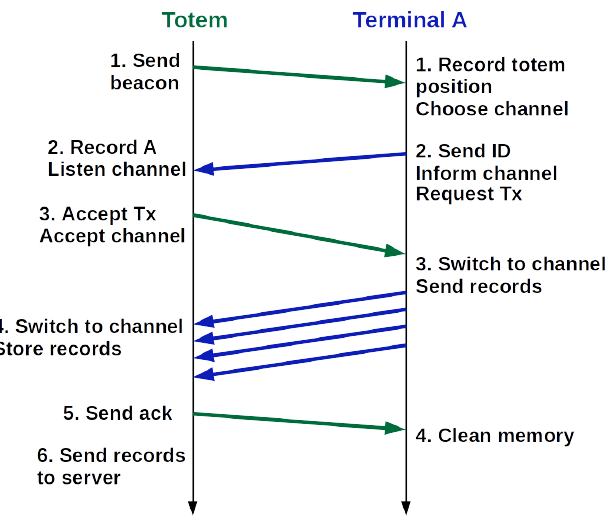
Figure 10. Communication between terminals.